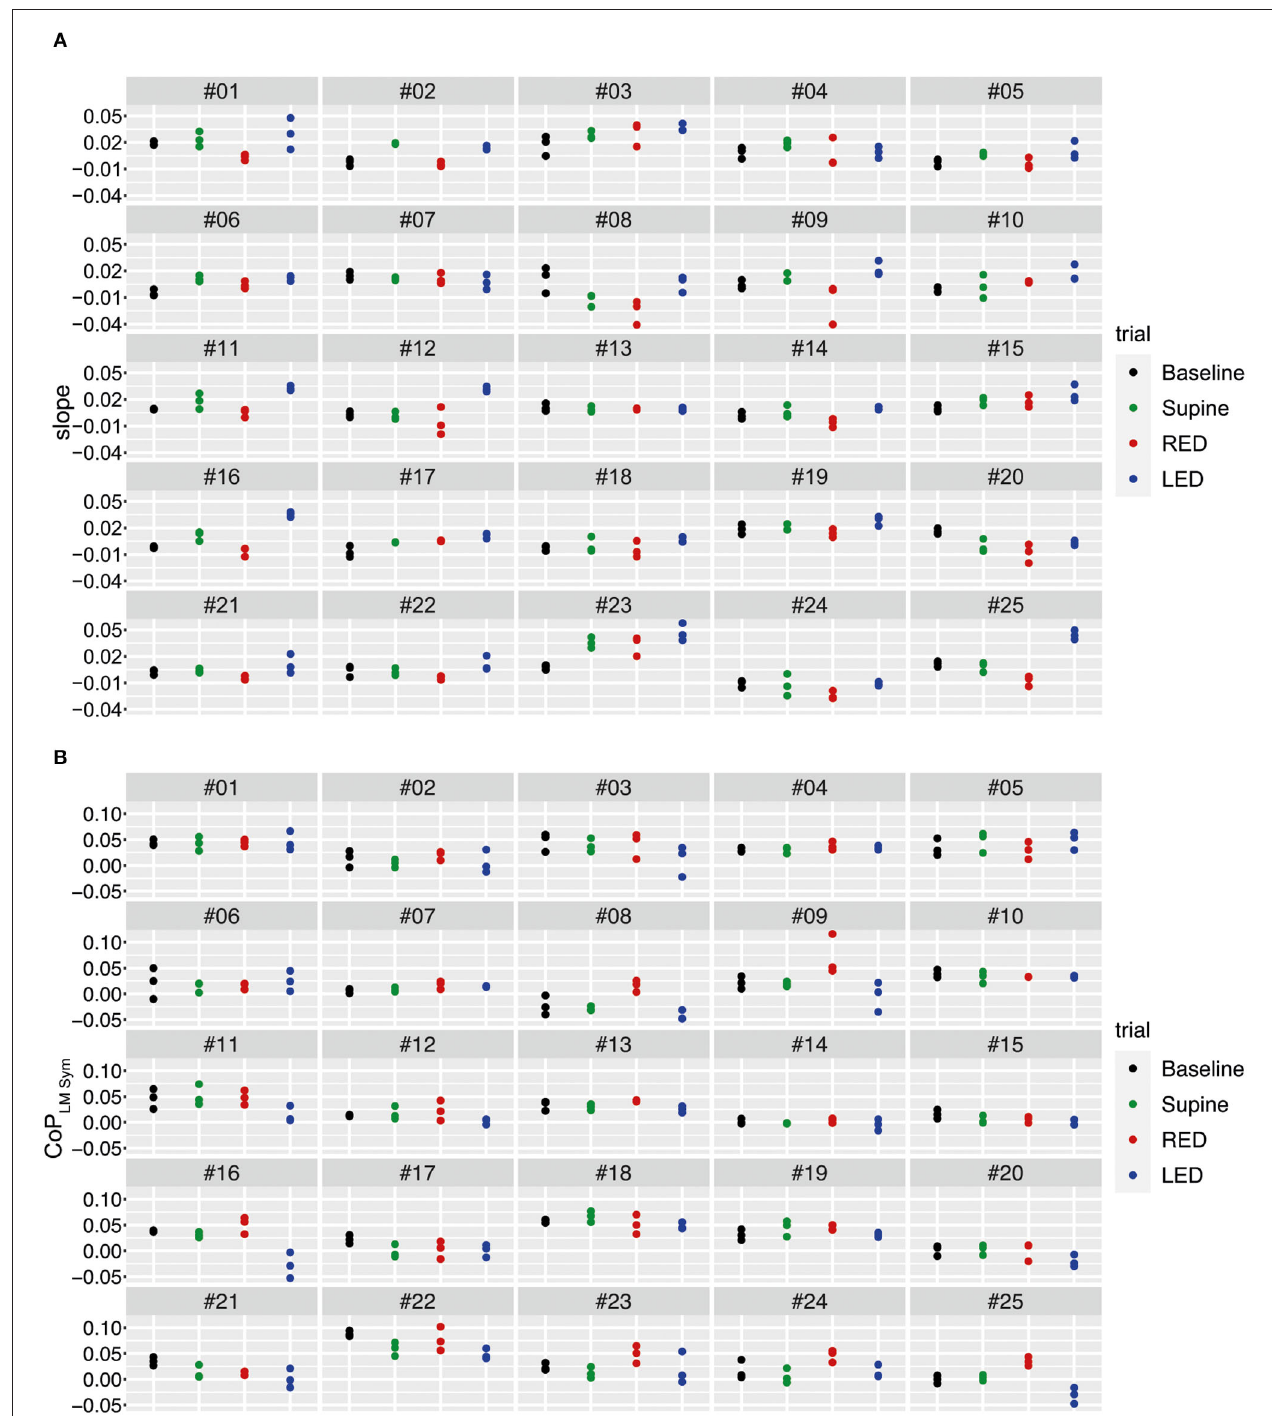
FIGURE 7 | The yaw slope (slope of the linear regression of the chest heading orientation) (A) and differences of the averaged LMCoP LM Sym (left–right) (B) per trial for the first WS for all 25 subjects. For (A) , positive slope values correspond to a rotation to the left. For (B) , positive differences of LM–CoP symmetries to the baseline indicate a pressure shift to the right, negative ones to the